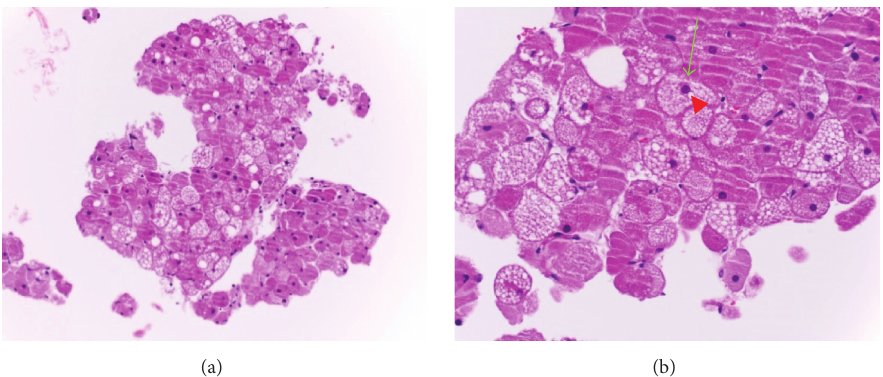
Figure5:H&E,40x(a)and200x(b),respectively,demonstratingsheetsofcellsresemblingbrownfat.Thehigherpowerexaminationrevealing well demarcated granular, multivacuolated eosinophilic cells (green arrow in (b)) with small centrally placed nuclei (red arrow head in